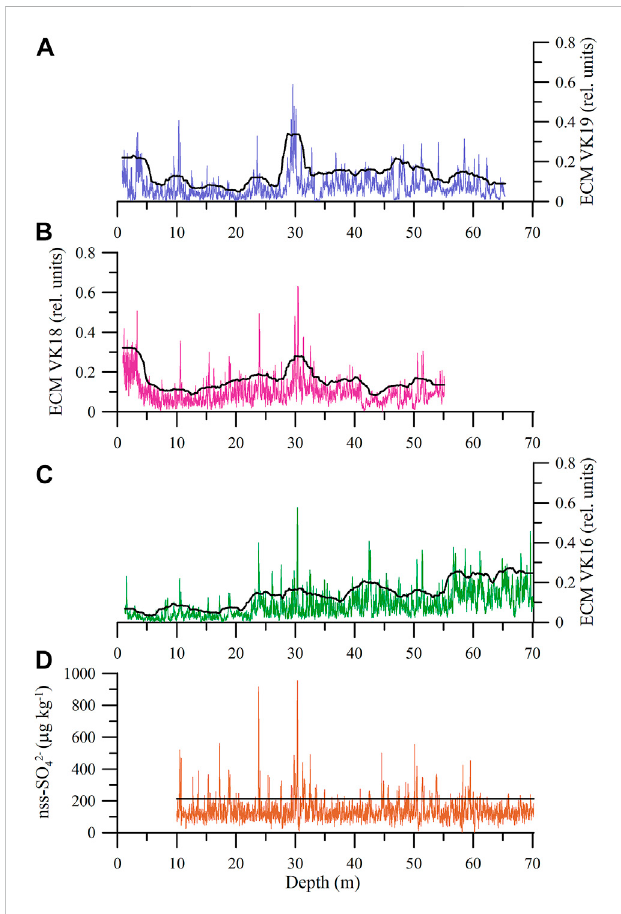
The electrical conductivity (ECM) pro fi les from cores (A) VK19, (B) VK18 and (C) VK16, and (D) the non-sea-salt SO 4 2- concentration in 9.90 – 70.20 m interval of VK16 core. The black lines are the cut-off valuesto separatethevolcanicpeaksfromthebackground(seethe text for